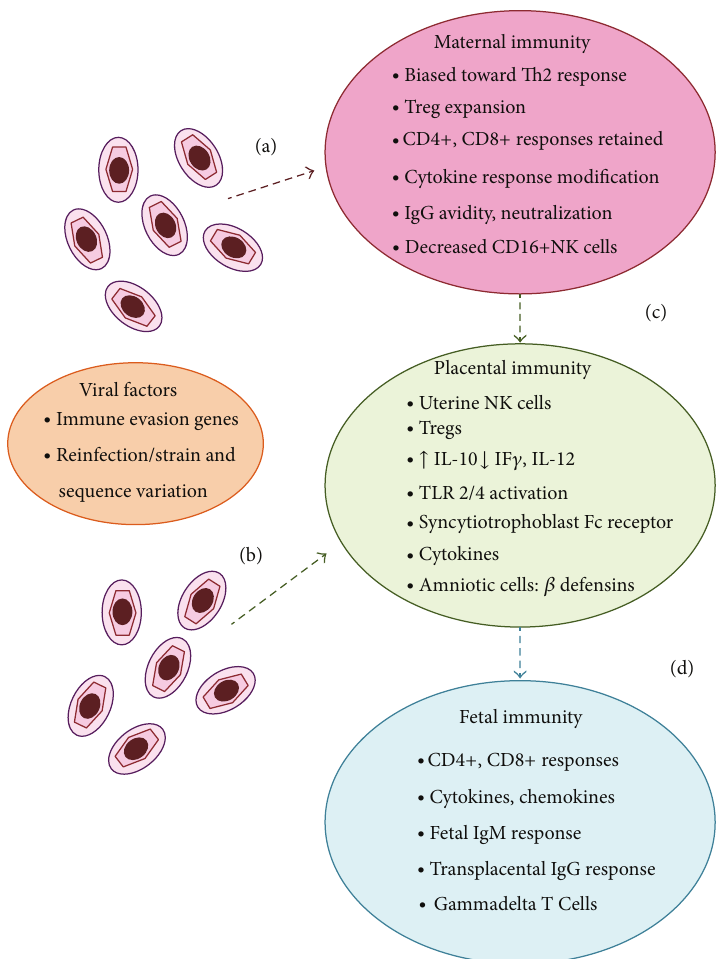
Figure 1: Schematic representation of pathways of CMV to the fetus and immune responses potentially important in transmission and prevention. The figure emphasizes the immunological milieu of pregnancy and some of the known immune adaptations associated with pregnancy. Left side of figure, CMV is known both to encode a plethora of immune evasion genes that subvert immune clearance of infection and to demonstrate substantial strain variation that can promote reinfection of already-immune hosts. Virus is believed to reach the placenta via the maternal compartment (a) or ascending infection via local extension in the reproductive tract (b). Although maternal antibody, CD4+, andCD8+responsesaregenerallyintactinpregnancy,therearealterationsinTh1/Th2cytokinebalance;alterationsinNKcellsubpopulations; increasedTregs;andmodifiedcytokineresponses.Theuterinemicroenvironmentinpregnancymayalsoplayaroleindirectlocalextensionof CMV following virus exposure or reactivation (b), driven in part by increased localized IL-10 expression. Irrespective of the route of infection, the immunological profile of the placenta may either facilitate CMV transmission or inhibit it. Factors that may promote transmission include the less efficient killing potential of uNK cells; decreases in cytokines such as IL-12 and IF- 𝛾 ; and the potential translocation of CMV particles across the syncytiotrophoblast if low avidity IgG is present. Factors that inhibit transmission include chemokines and 𝛽 -defensins and, if present, high avidity neutralizing antibody, which may render virus noninfectious. Once virus enters the fetal compartment, the impaired capacity of fetal CD4+ to proliferate in response to CMV may impair immune control. The presence of transplacentally acquired IgG is believed to ameliorate the severity of disease. There is evidence that CD8+ cells, chemokines, and gammadelta T cells contribute to antiviral immunity in the fetal immune